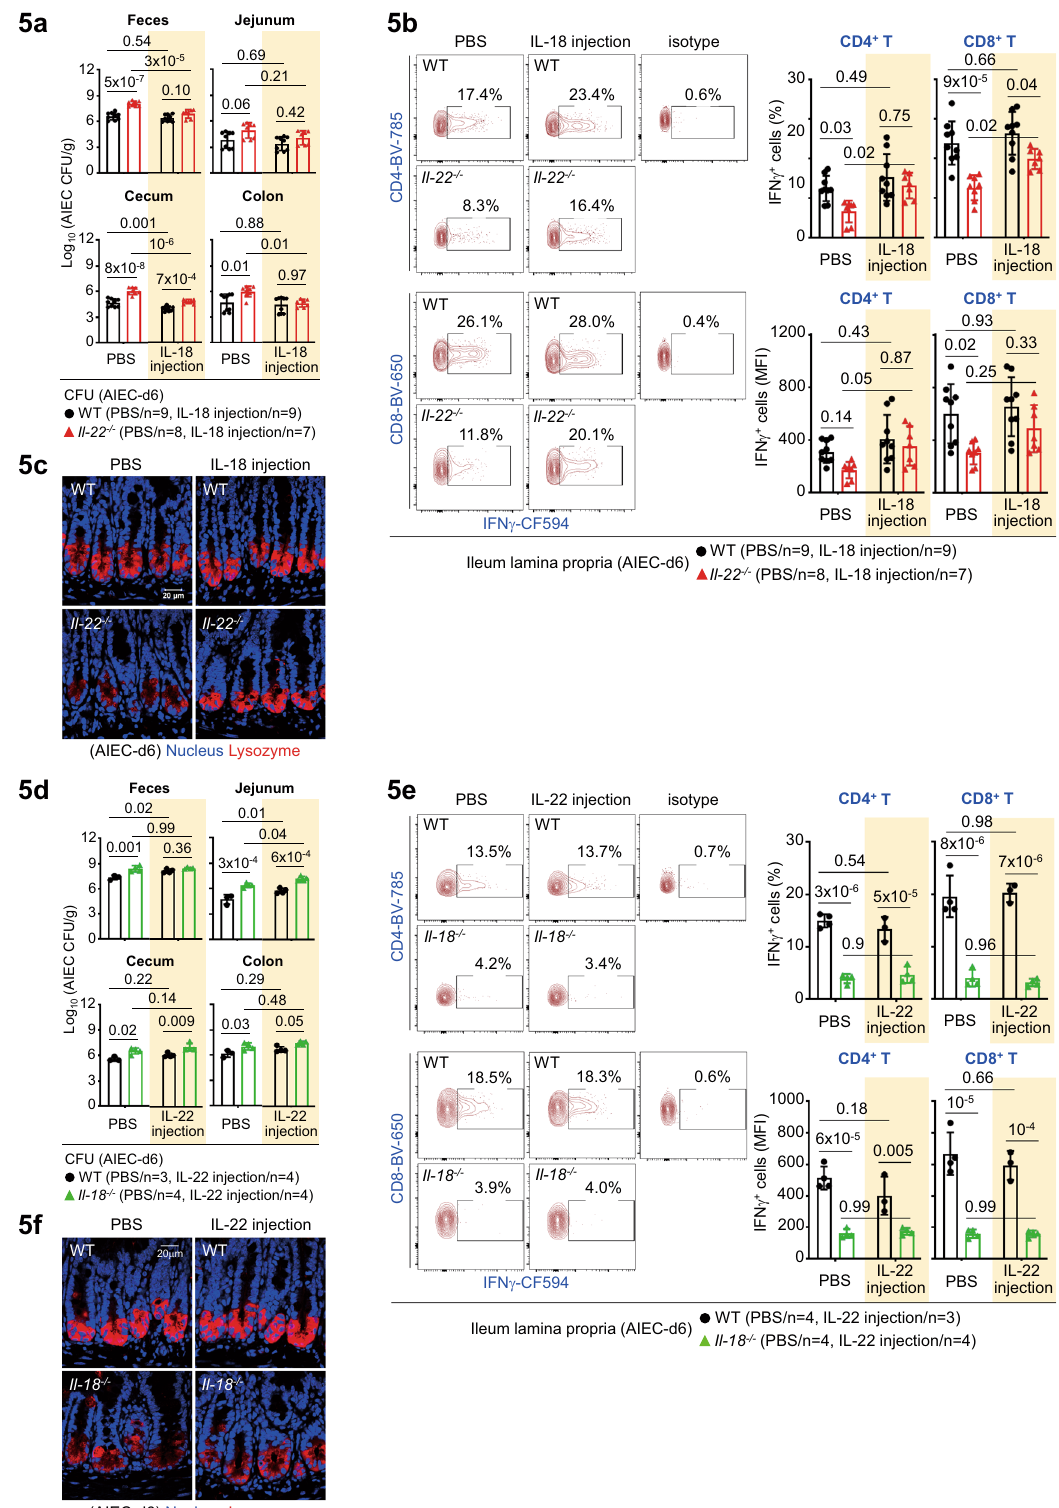
mucin secretion in wild-type mice but this process was almost abolished in Il-22 − / − or Il-18 − / − mice (Fig. 8b and Supplementary Fig. 9c, lower panels). Further analysis of IL-18-injected Il-22 − / − mice con fi rmed that IL-18 indeed promote mucin secretion from Goblet cells during AIEC infection (Fig. 8c). In contrast, IL-22 injection into Il-18 − / − mice failed to promote mucin